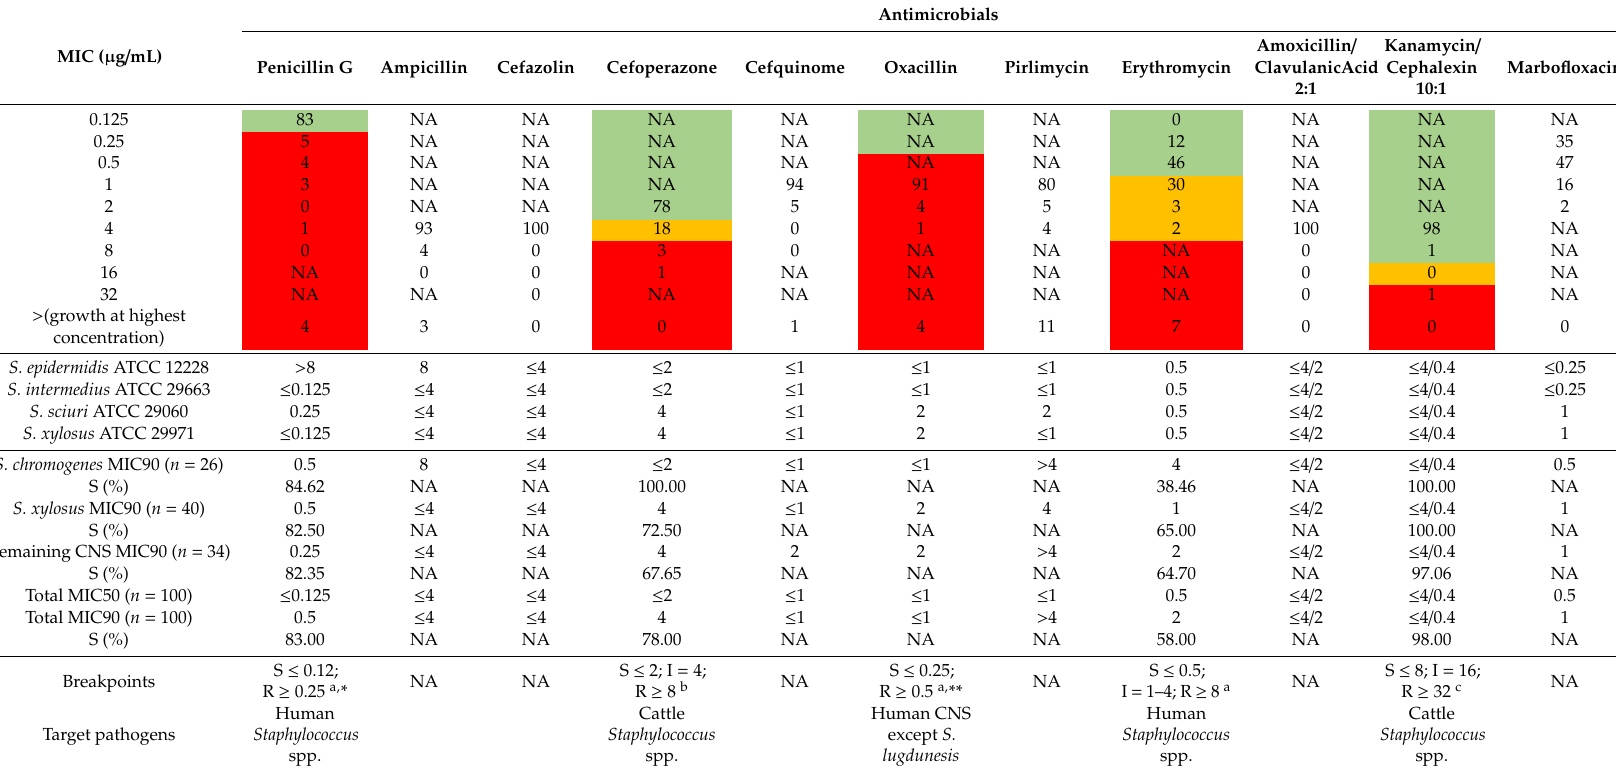
Table 4. Minimal inhibitory concentration of coagulase-negative staphylococci ( n = 100) isolated from bovine mastitis in Austria.